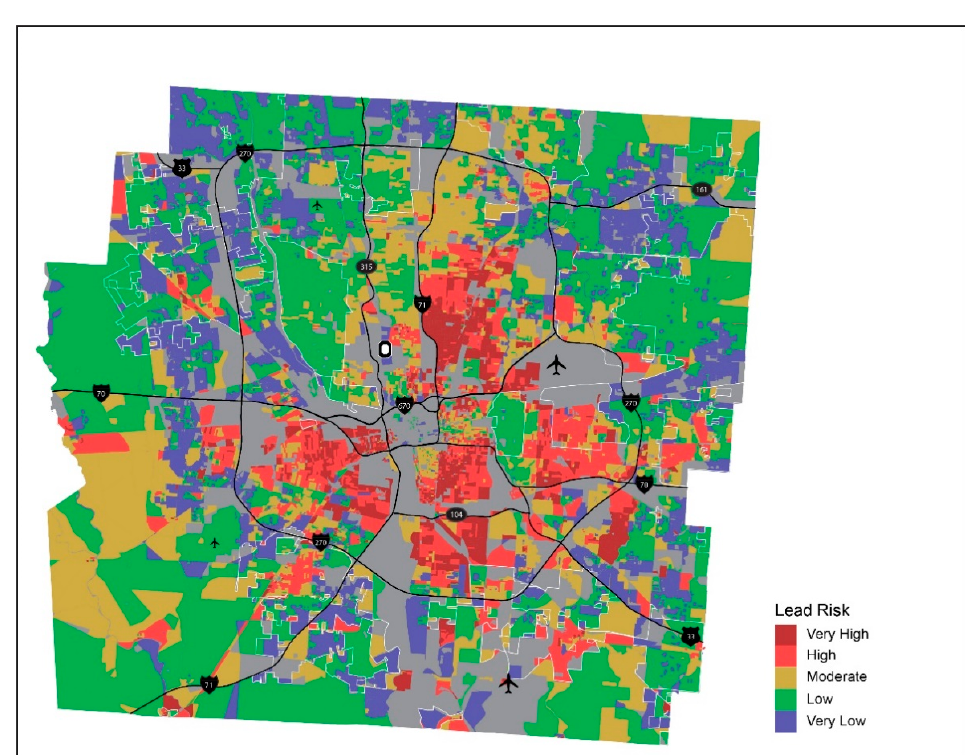
Figure 3. Lead risk by census block—Franklin County, Ohio .